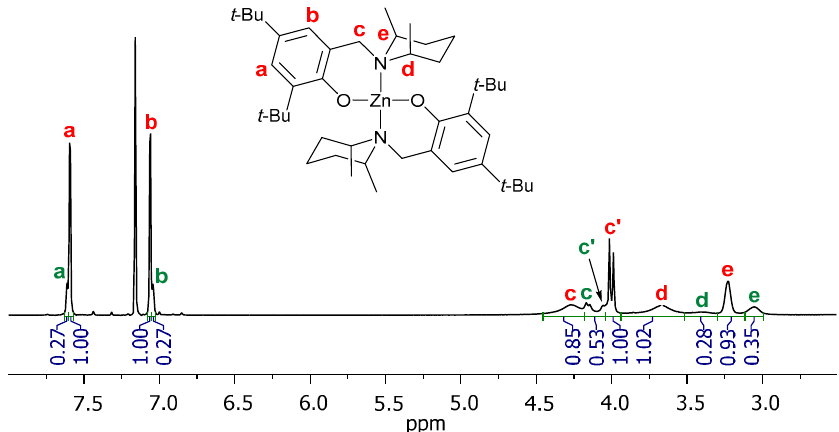
Figure 4. Fragment of 1 H NMR spectrum of (L dmp ) 2 Zn (C 6 D 6 ). Major form: red, minor form: green.